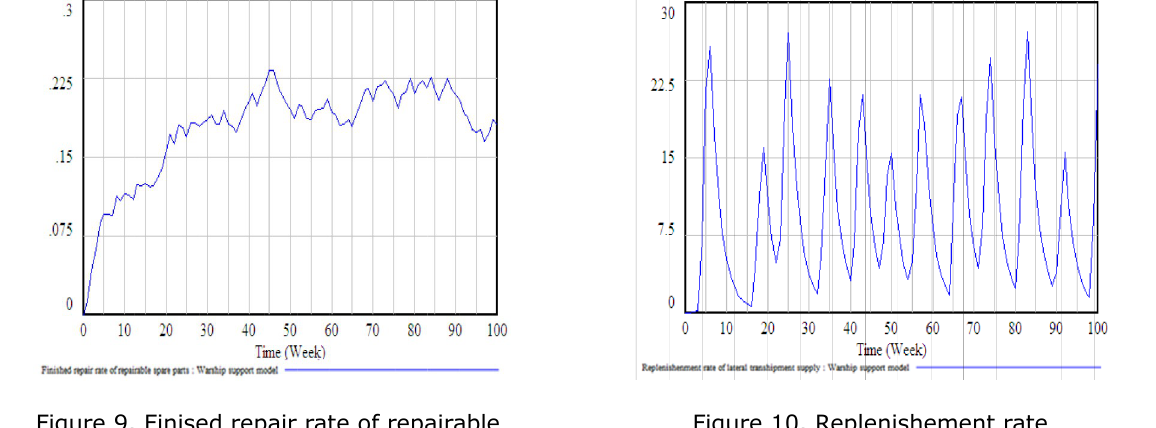
Figure 10. Replenishement rate of lateral